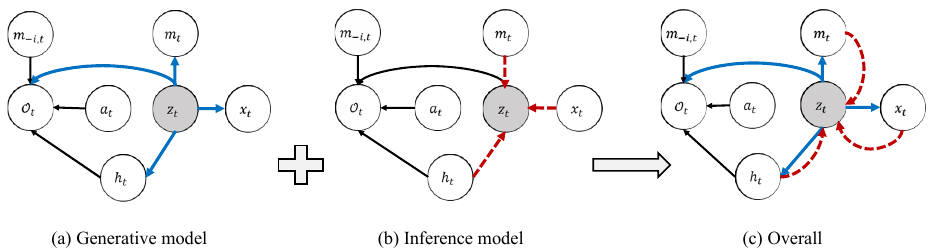
Figure 2. Graphical model with latent variable model. In ( a ), the solid blue arrows represent the generative model p θ ( z t ) p θ ( x t | z t ) p θ ( m t | z t ) p θ ( h t | z t ) . In ( b ), the dashed red arrows denote the variational approximation q φ ( z t | x t , m t , h t ) . m − i , t is the message that comes from other agents. The overall computational paths of CICM is shown in ( c